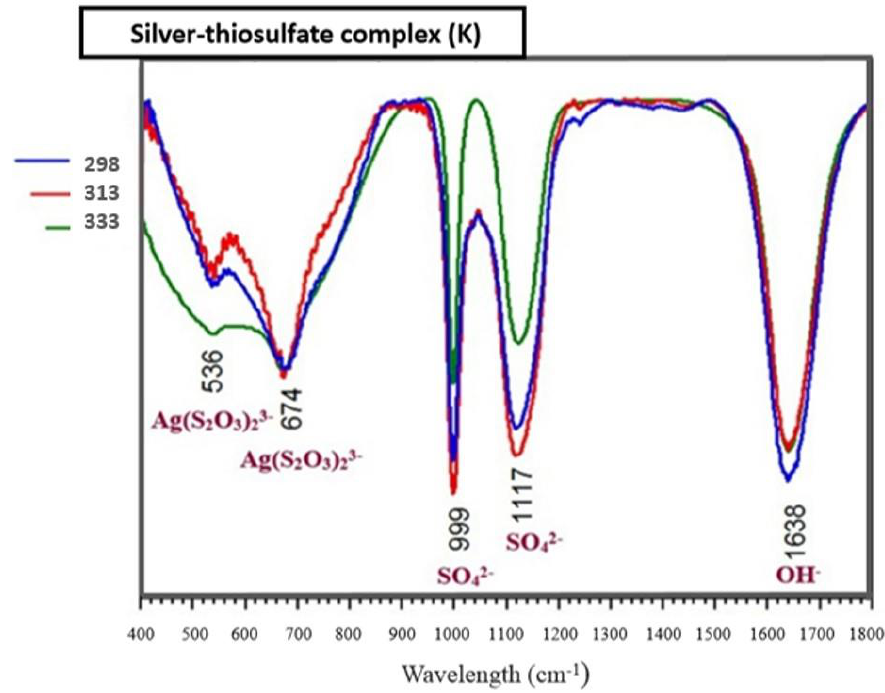
Figure 10. Infrared spectrum corresponding to silver thiosulfate at 298, 313, and 333 K.